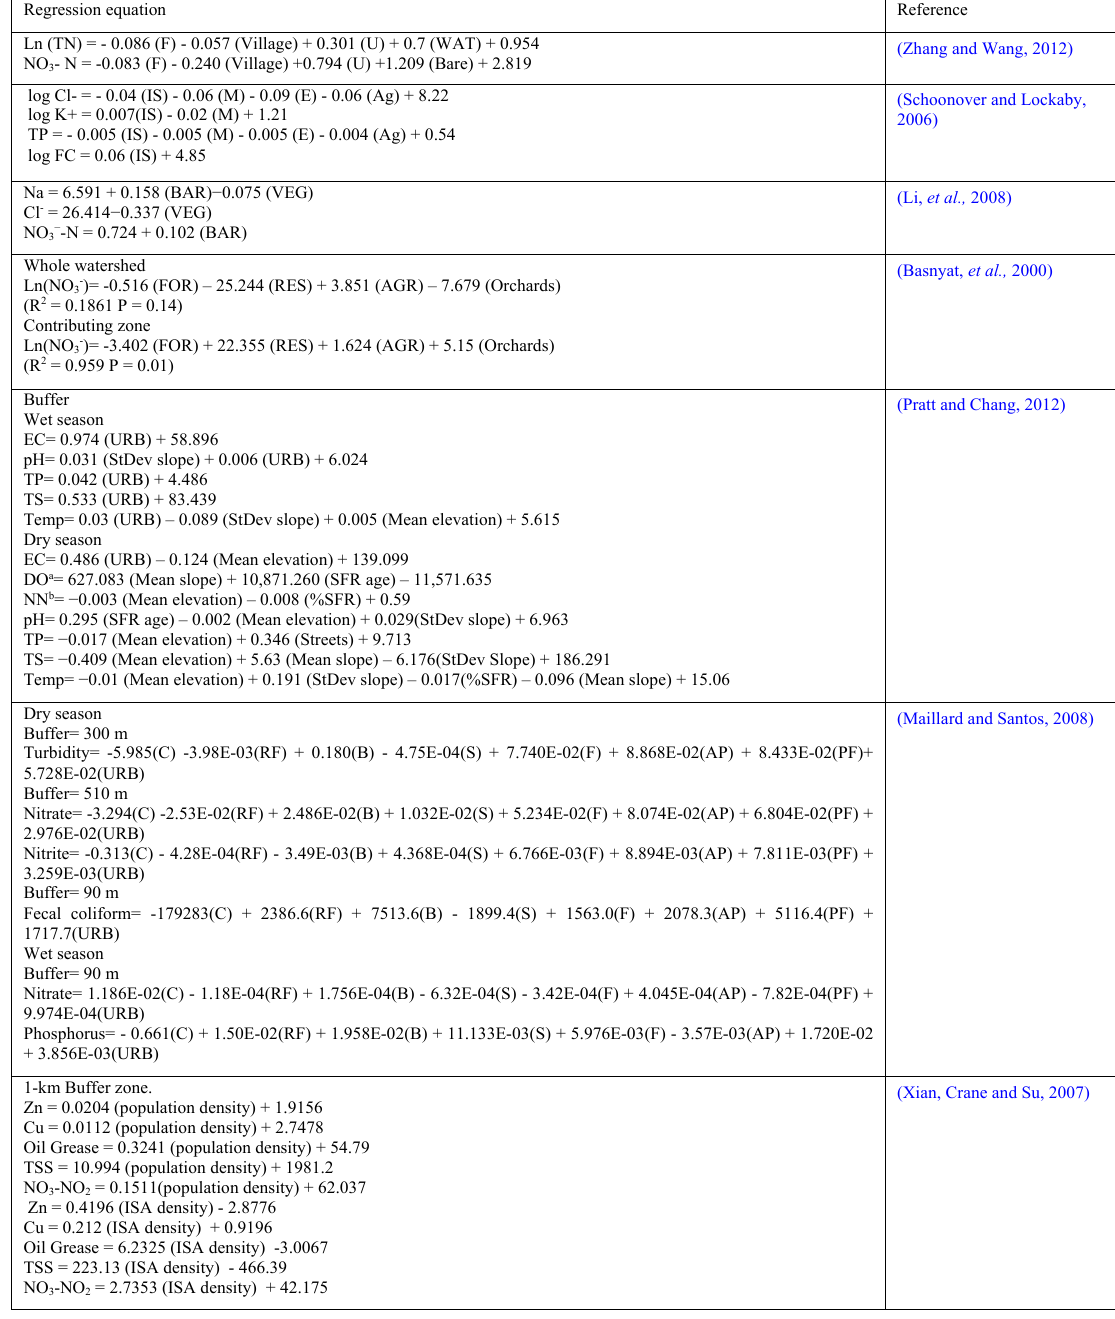
Table 3: Regression equation between water quality indicators and land use